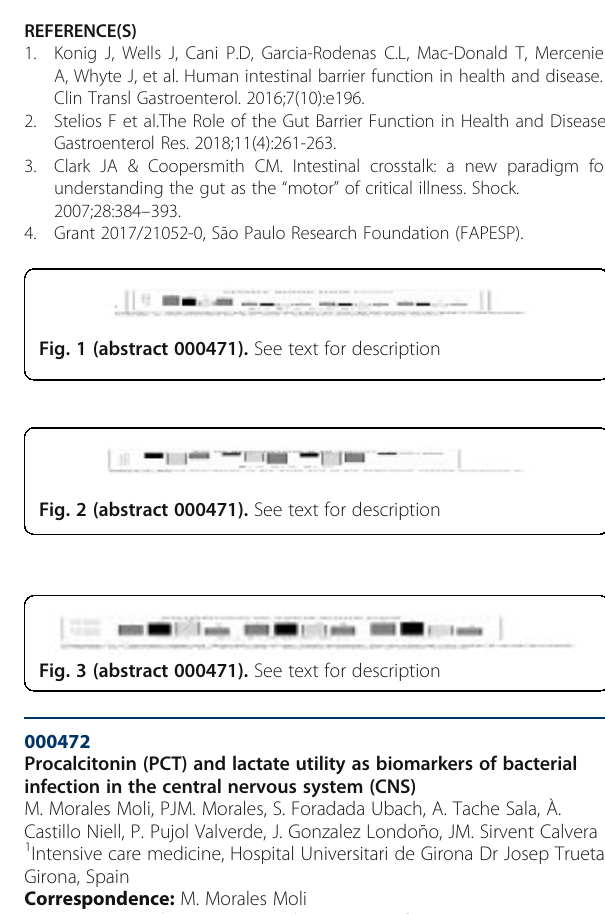
Table 1 (abstract 000472). See text for